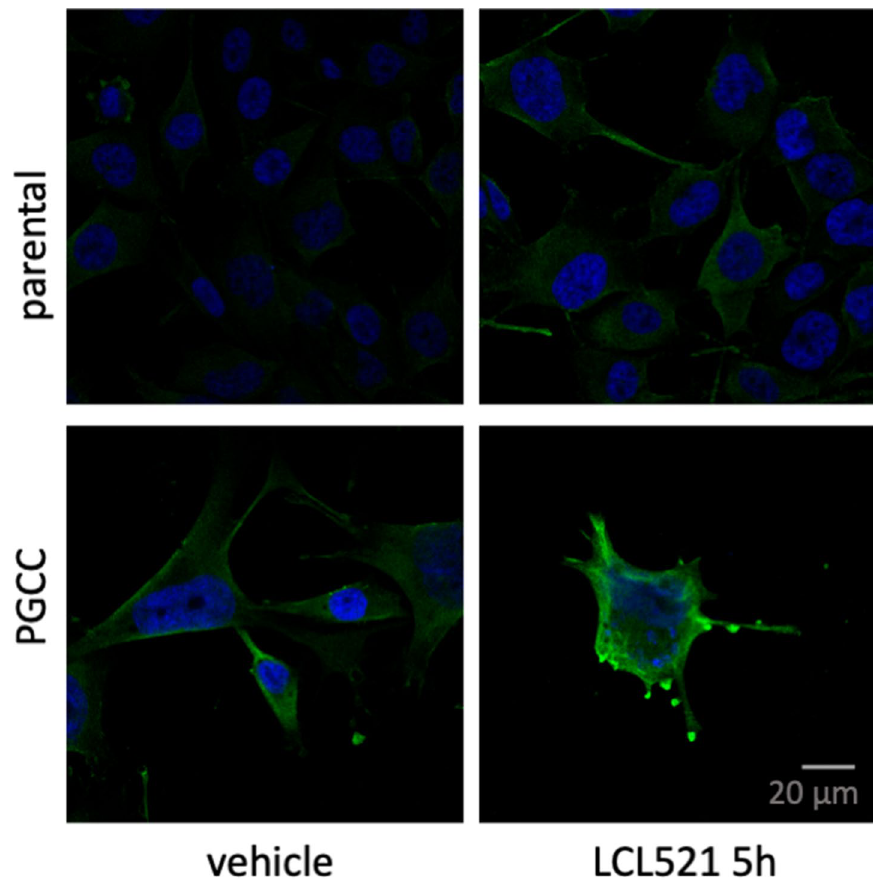
Figure 1. Ceramide accumulation after 5 h of LCL521 treatment. Parental and PGCC cells were treated with vehicle or 5 μM LCL521 for 5 h and ceramide staining analyzed by confocal microscopy. The green signal indicates ceramide staining. Nuclei are identified by DAPI